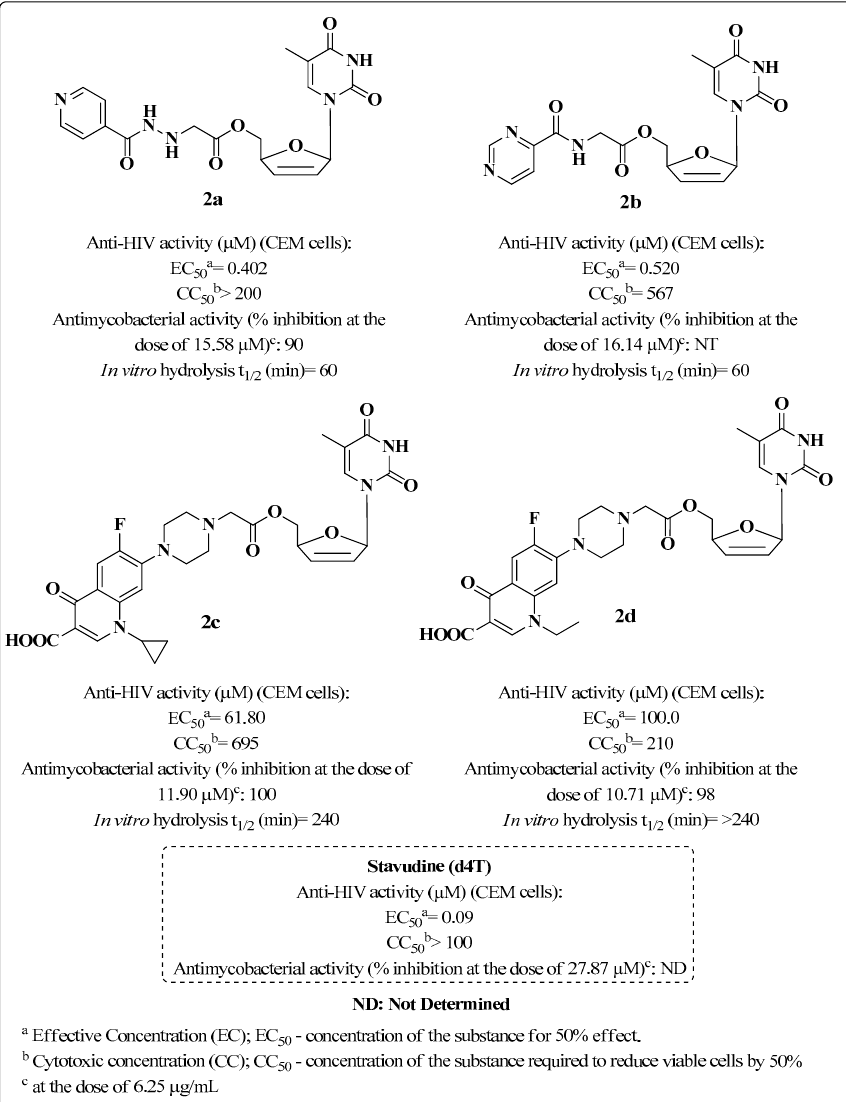
Figure 7. Anti-HIV and anti-MTB activity of d4T-derived Compounds 2a – d , synthesized by Sriram et al. in 2004 [79]. Sriram et al. in 2004